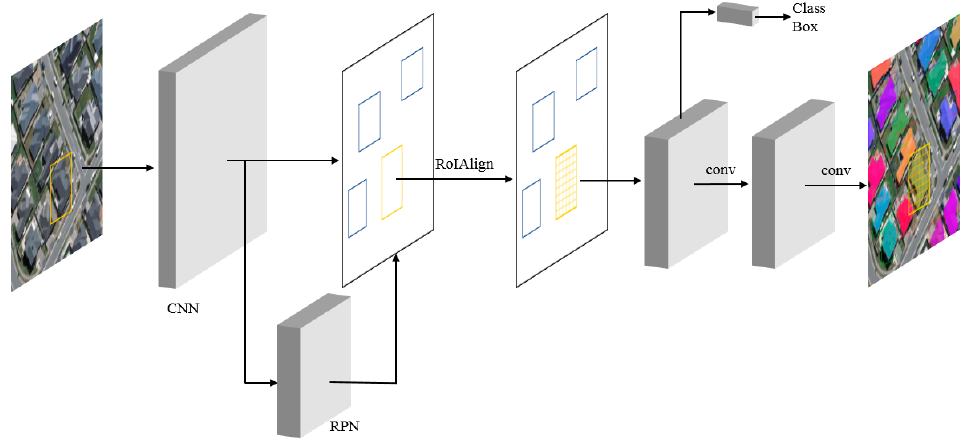
Figure 2. The Mask R-CNN framework for instance segmentation.